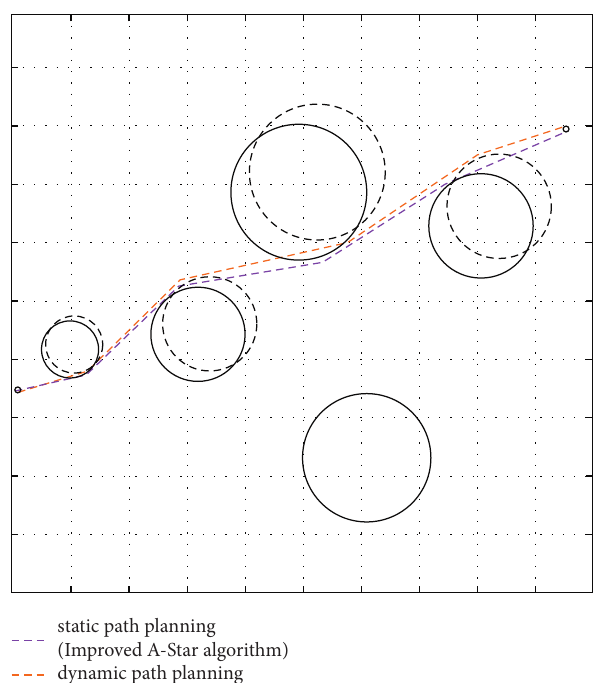
Figure 24: The results of dynamic path planning from Algiers to